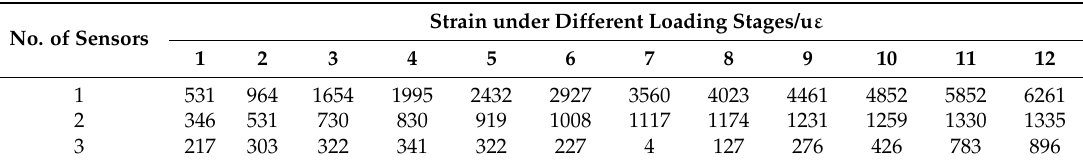
Table 5. Strain values of three FBG sensors in loading stage.